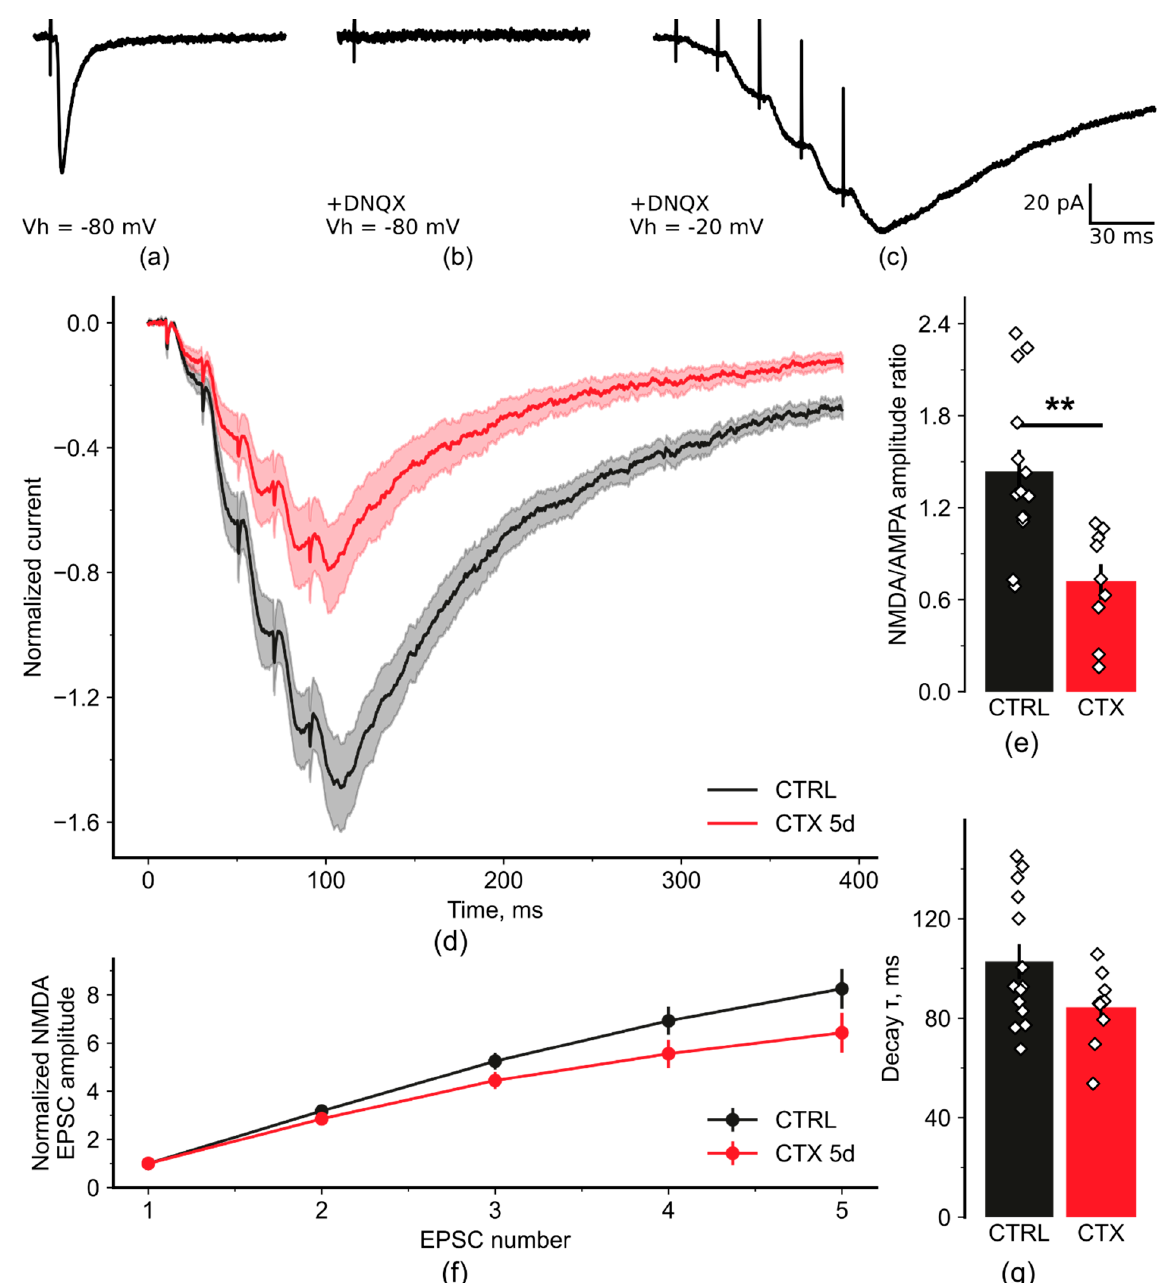
Figure 3. The N-methyl-D-aspartate receptor (NMDAR)/ α -amino-3-hydroxy-5-methyl-4-isoxazolepropionic acid receptor (AMPAR) ratio was significantly reduced in the CTX-treated animals, with no effect on NMDAR-mediated current kinetics. ( a ) AMPAR-mediated evoked excitatory postsynaptic currents (eEPSCs) recorded at − 80 mV in the presence of GABAaR and GABAbR antagonists bicuculline (10 µ M) and CGP 55845 (5 µ M). ( b ) Complete block of the AMPAR-mediated current by bath-applied DNQX (20 µ M). ( c ) NMDAR-mediated eEPSCs recorded in the same neuron in the presence of DNQX at − 20 mV with the same stimulus current amplitude. ( d ) Average NMDAR-mediated currents normalized by the AMPAR- mediated eEPSC amplitude for each group. The transparent areas represent the standard error of the mean for each trace. ( e ) NMDA/AMPA ratios measured as the peak NMDAR-mediated current amplitude (for the last EPSC) divided by the peak AMPAR-mediated current amplitude. The asterisk represents a significant difference according to the Student’s t -test ( p < 0.01). ( f ) Average NMDAR-mediated peak eEPSC amplitudes normalized by the first EPSC amplitude for each recorded cell. ( g ) Decay τ measured at the 80–20% amplitude of the last NMDAR-mediated EPSC in the train using a monoexponential approximation. ** p < 0.01, a significant difference versus the control group according to the Student’s t